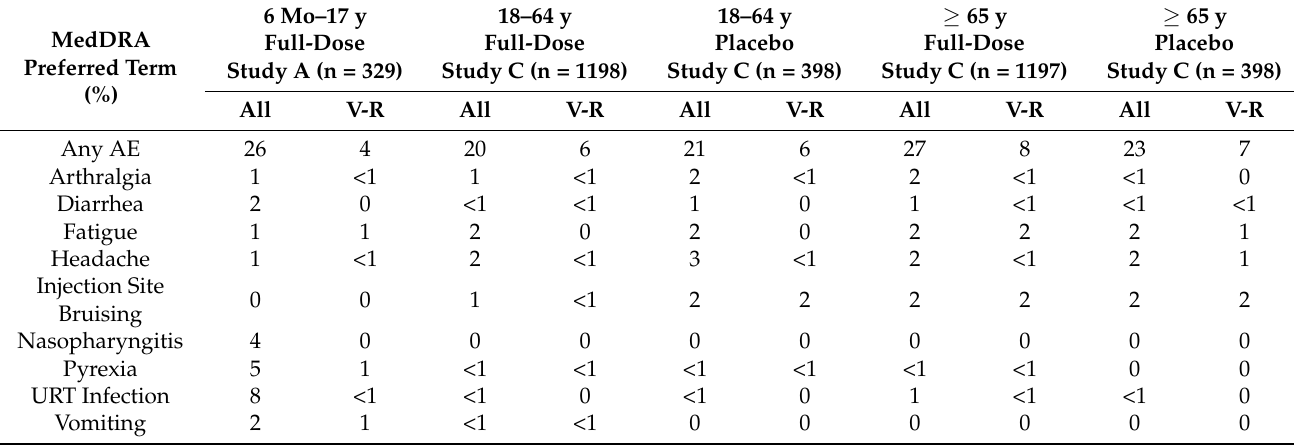
Table 8. Percentages of subjects experiencing any or at least possibly related unsolicited adverse events within 21 days of any vaccination (Day 1–43; MedDRA preferred terms occurring in ≥ 2% of any